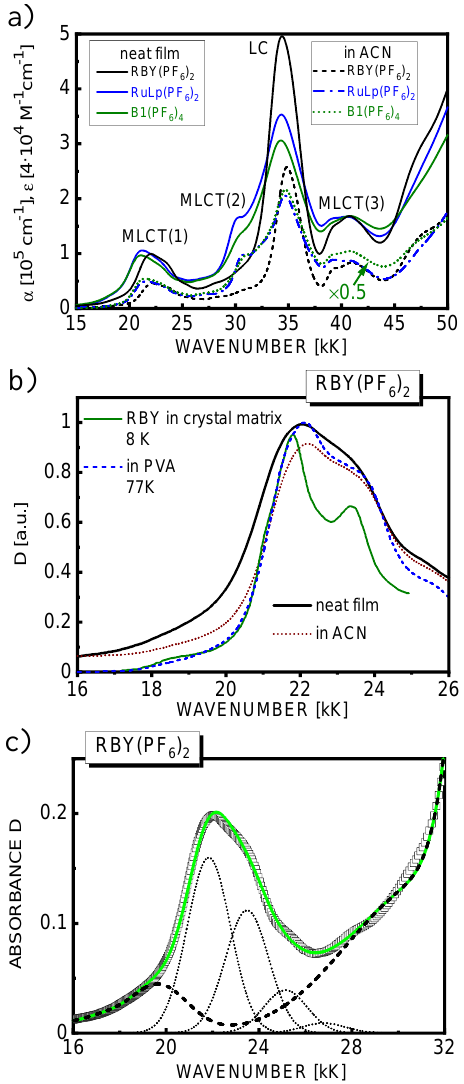
Figure 2. ( a ) Absorption spectra of RBY(PF 6 ) 2 , RuLp(PF 6 ) 2 , and B1(PF 6 ) 4 in neat films (solid lines) and in ACN solution (broken lines)—for colors, see the website. The molar extinction coefficient ( ε ) of B1(PF 6 ) 4 was multiplied by 0.5. The spectral ranges of the MLCT and LC excited states are also indicated; ( b ) Comparison of absorption spectra in the MLCT(1) range for RBY(PF 6 ) 2 : in a neat film (thick solid line), in an ACN solution (dotted line), in a PVA matrix at 77 K (dashed line, data taken from [30]), and for RBY in the crystal matrix Zn(bpy) 3 (BF 4 ) 2 at 8 K (thin solid line, data from [12]); ( c ) Absorption spectrum of a 46 nm − thick RBY(PF 6 ) 2 film (squares) with the total fit (solid line) and its Franck–Condon components (dotted lines) in the MLCT(1) range ( ν 0 = 21.84 kK, ∆ ν = 1.65 kK, w = 2.2 kK and S = 0.7). The background from the lower energy and higher energy states is repre- sented by a dashed